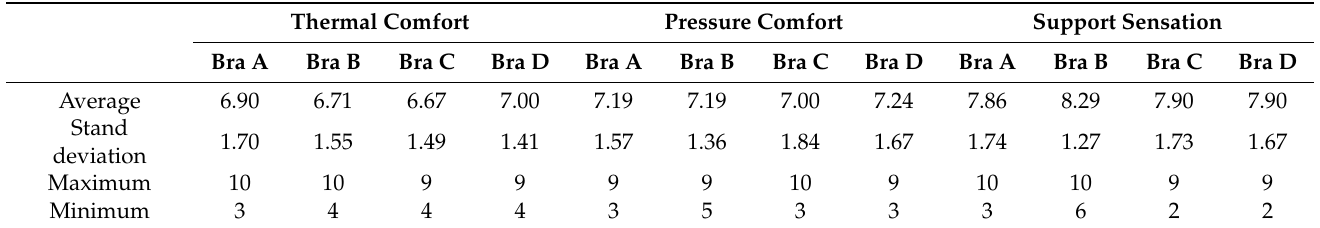
Figure 8. FLIR images for Stages I to II: Bra Conditions ( a ) A; ( b ) B; ( c ) C; and ( d ) D in frontal view. Table 5. Subjective sensation rating of pressure comfort and support sensation of 4 bra